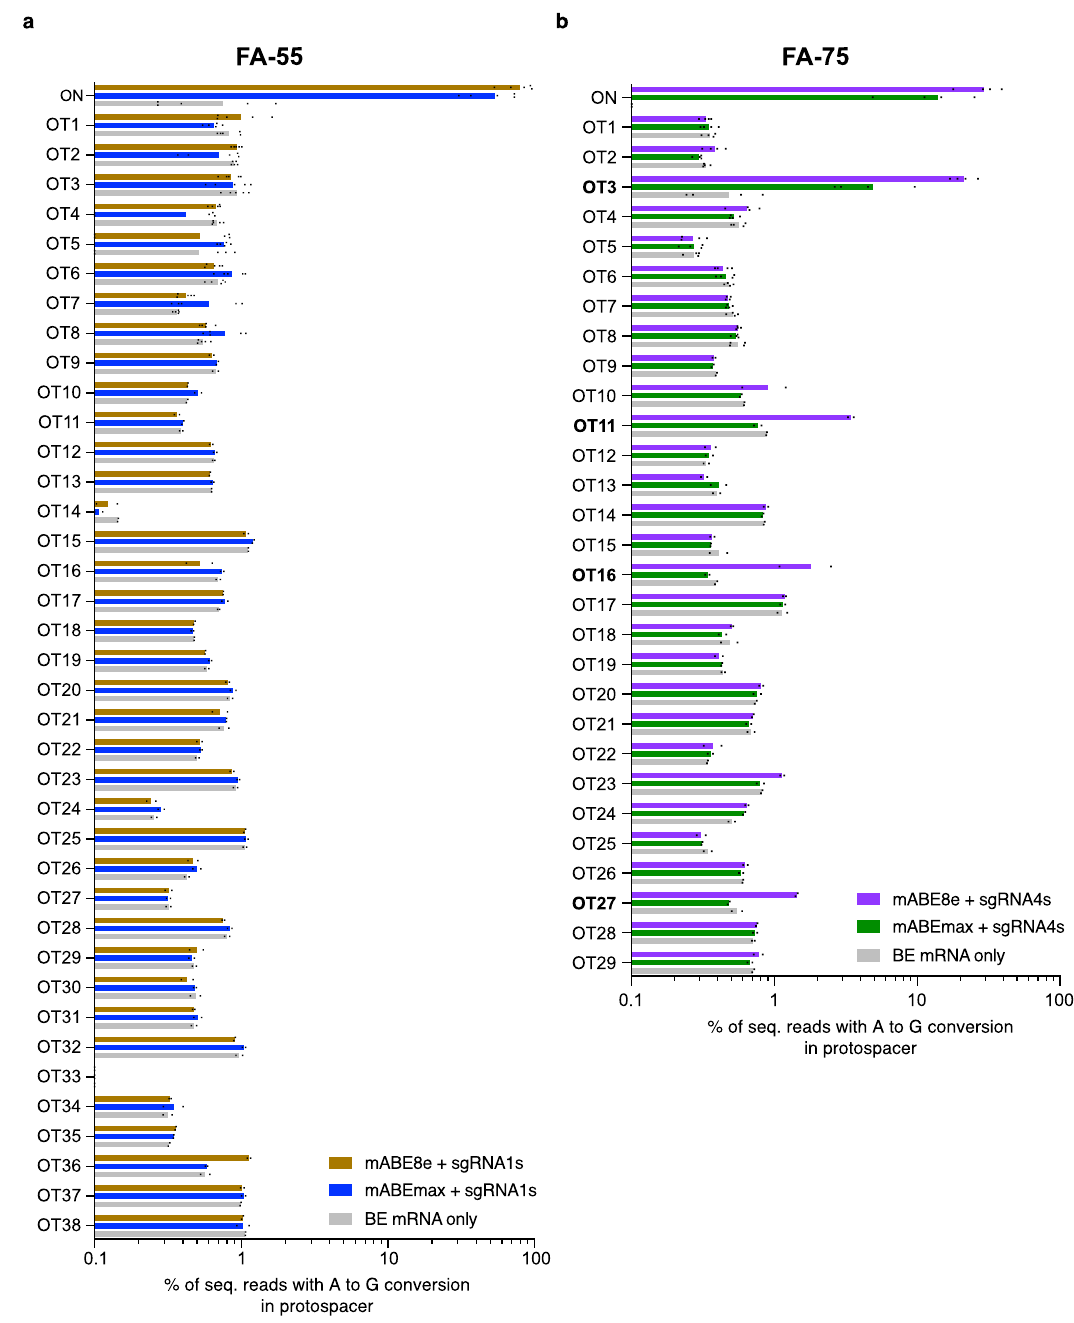
and OT27 are marked in bold, indicating potential off-targets for sgRNA4. For FA- 55, 5 biological replicates are shown for the on-target site and OT1-8 while 2 bio- logicalreplicatesareshownforOT9-38.ForFA-75,4biologicalreplicatesareshown forthe on-targetsite andOT1-8 while 2biological replicatesare shownforOT9-29. Source data are provided as a Source Data fi